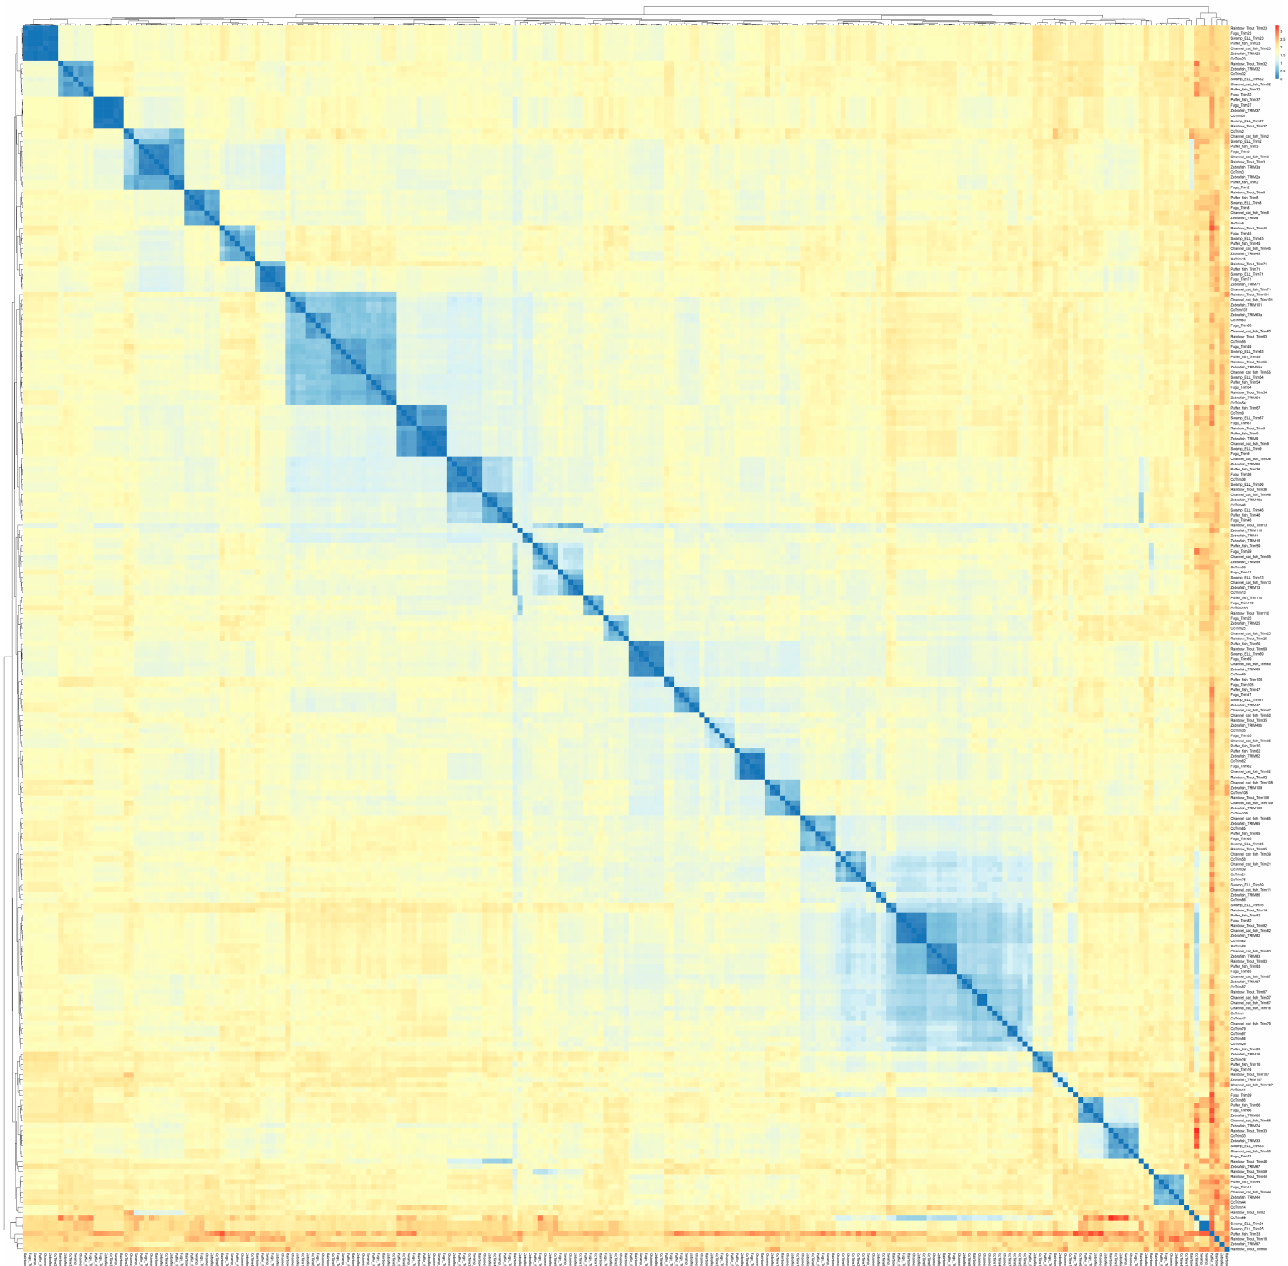
Figure 2. Heatmap based on the pairwise distance among amino acids of TRIM proteins from different teleost species (common carp, zebrafish, channel catfish, pufferfish, rainbow trout, fugu, and swamp eel). Different colors illustrate the heatmap ranging from blue (less distance value) to red (highest distance value). Each protein sequence was compared to find the mismatch at align position between common carp TRIMs and other teleost TRIMs. This analysis allowed the comparison of all sequences vs. all sequences. The cladogram across the top and left of the heatmap shows the evolutionary divergence based on distance values. Names are listed on the right and bottom of the diagram.